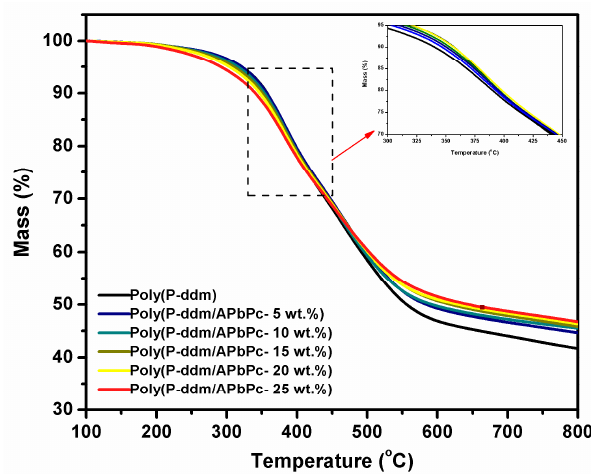
Figure 10. TGA curves of P-ddm/APbPc copolymers on different wt.% blending of APbPc. Table 5. TGA data for P-ddm/APbPc copolymers on different wt.% blending of APbPc.